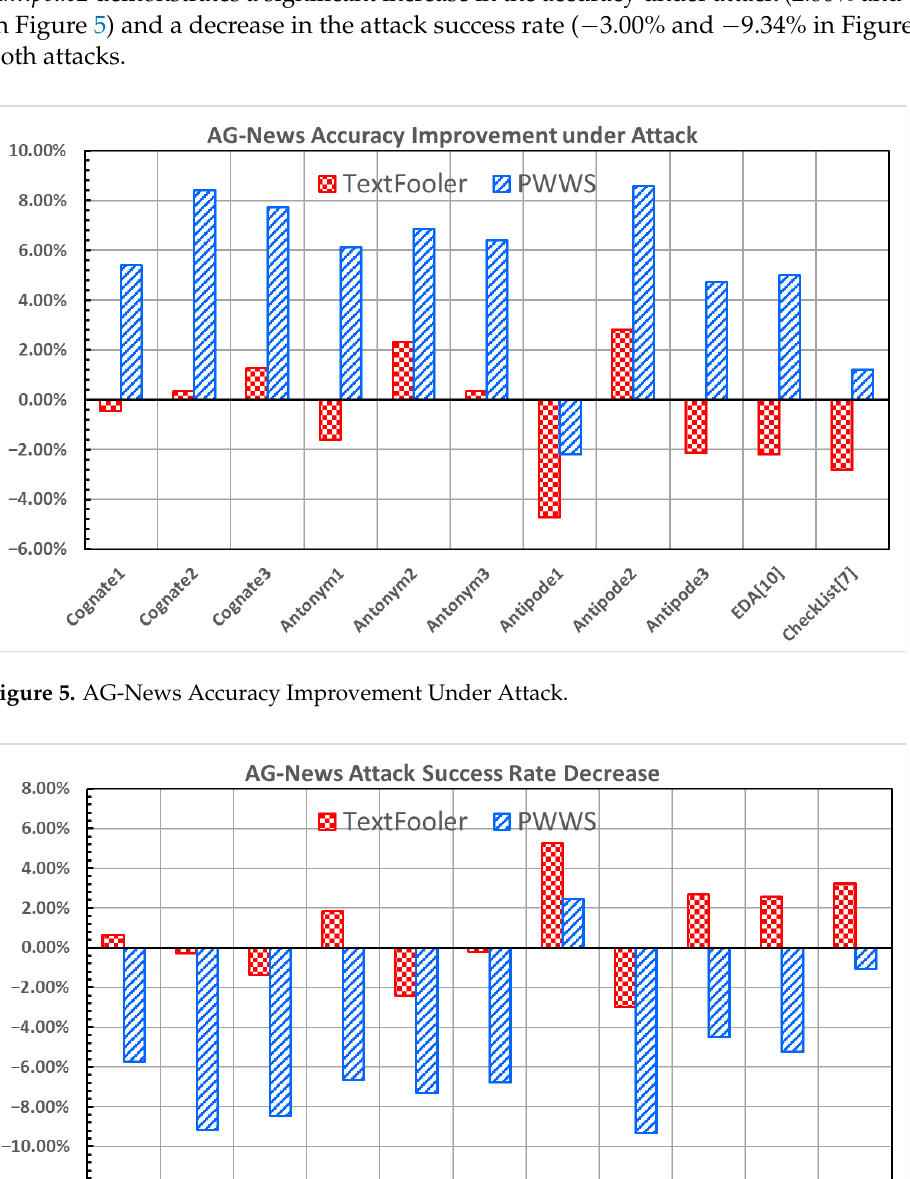
Figure 4. SMS-Spam Performance Improvement Results.